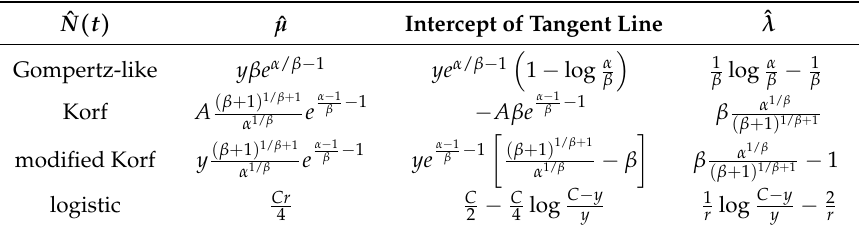
Table 4. The maximum specific growth rate, the intercept of the tangent line and the lag time for the considered growth